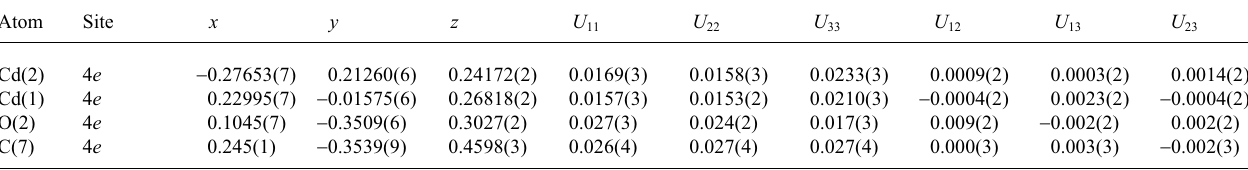
Table 3. Atomic coordinates and displacement parameters (in Å 2